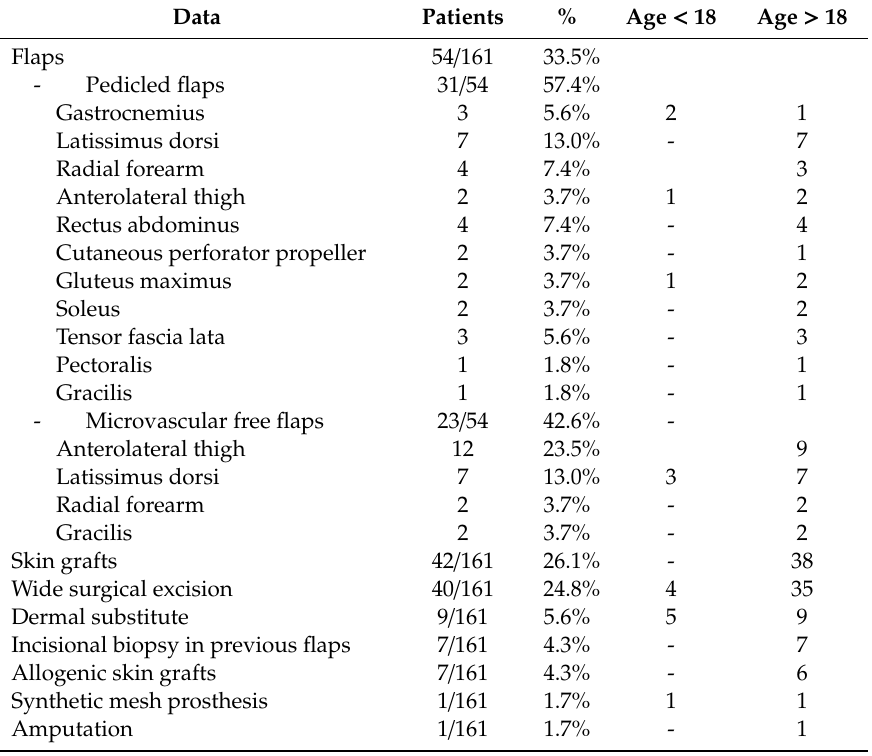
Table 3. Number of cases and relative percentages of each surgical procedure. The complete list of specific types of flaps has been exploded.